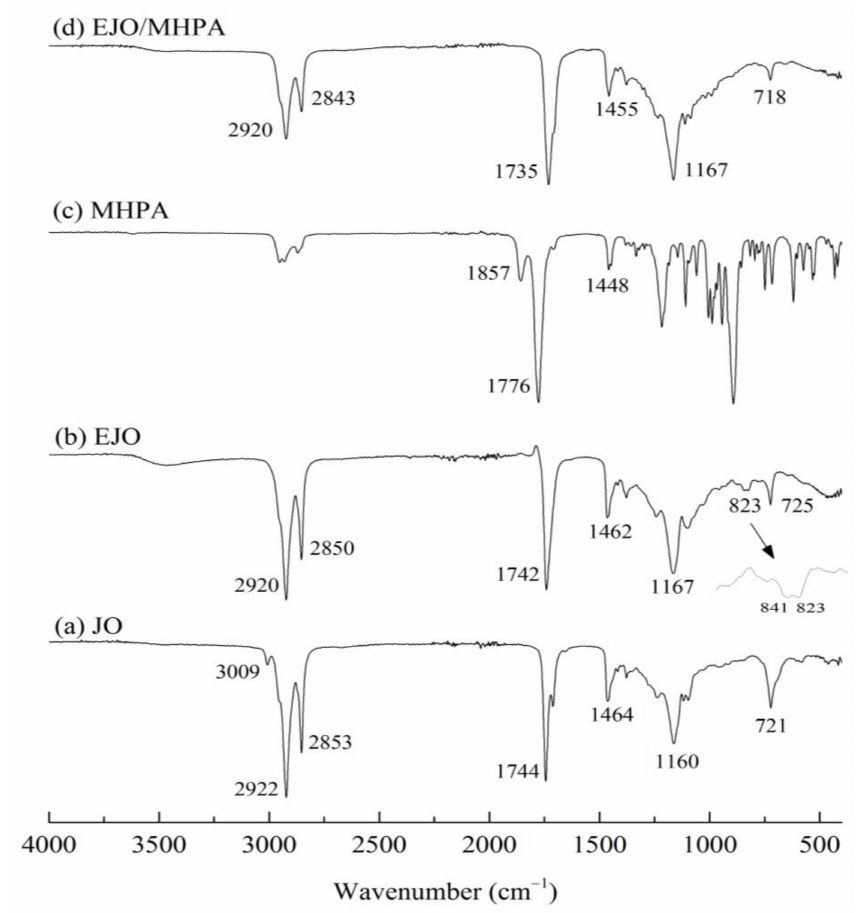
Figure 3. FTIR spectra of ( a ) JO, ( b ) EJO, ( c ) MHPA, and ( d ) EJO/MHPA